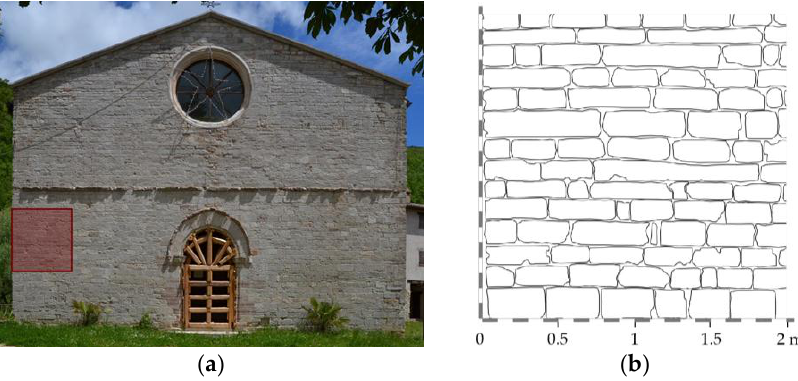
Figure 7. ( a ) Part of the investigated façade; ( b ) redrawn of a portion of the wall of the façade of the church (2.00 × 2.00 m).